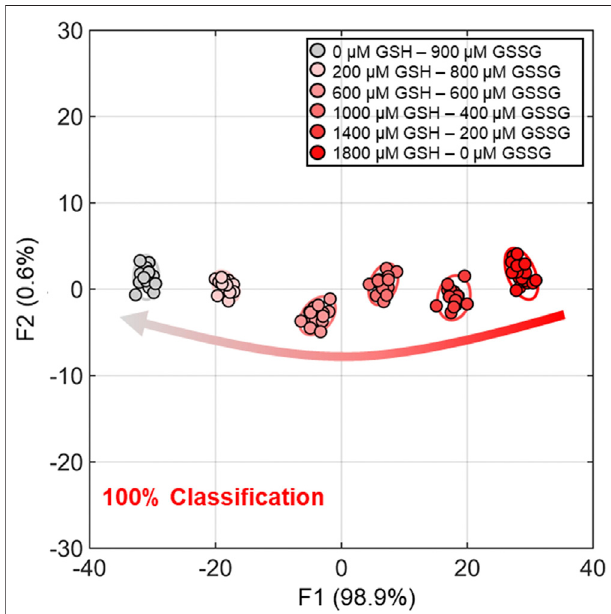
FIGURE3| SemiquantitativeLDAresultfordynamicmolarratiosofGSH and GSSG. The measurements were performed with eighteen repetitions for